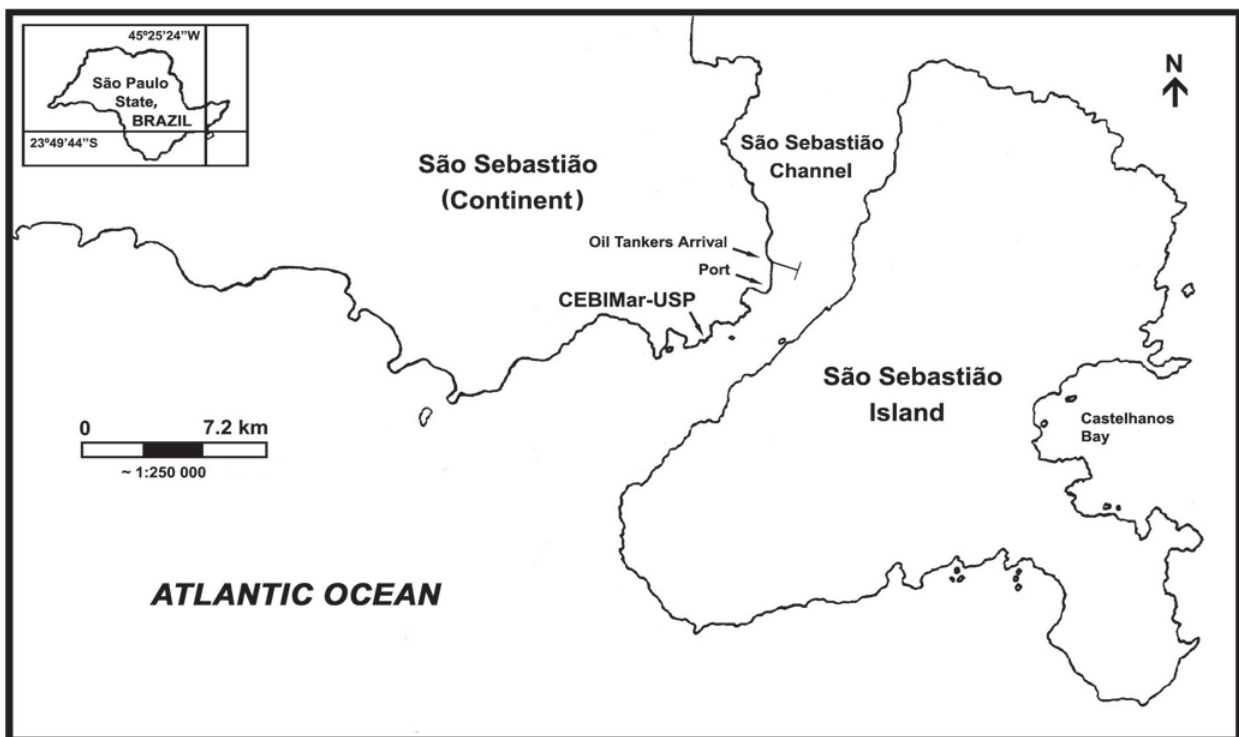
Fig. 1. Map indicating the location of the study area (São Sebastião Channel) and the marine station of the University of